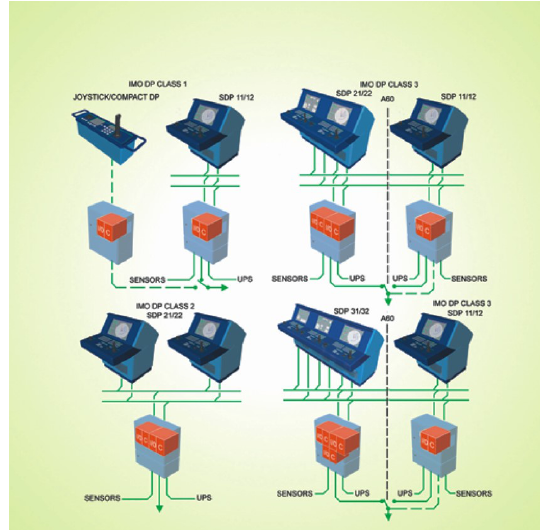
Figure 8: Various configurations of Simrad DP (SDP) systems required to satisfy the demands of different DP classes according to IMO regu- lations. Illustration: